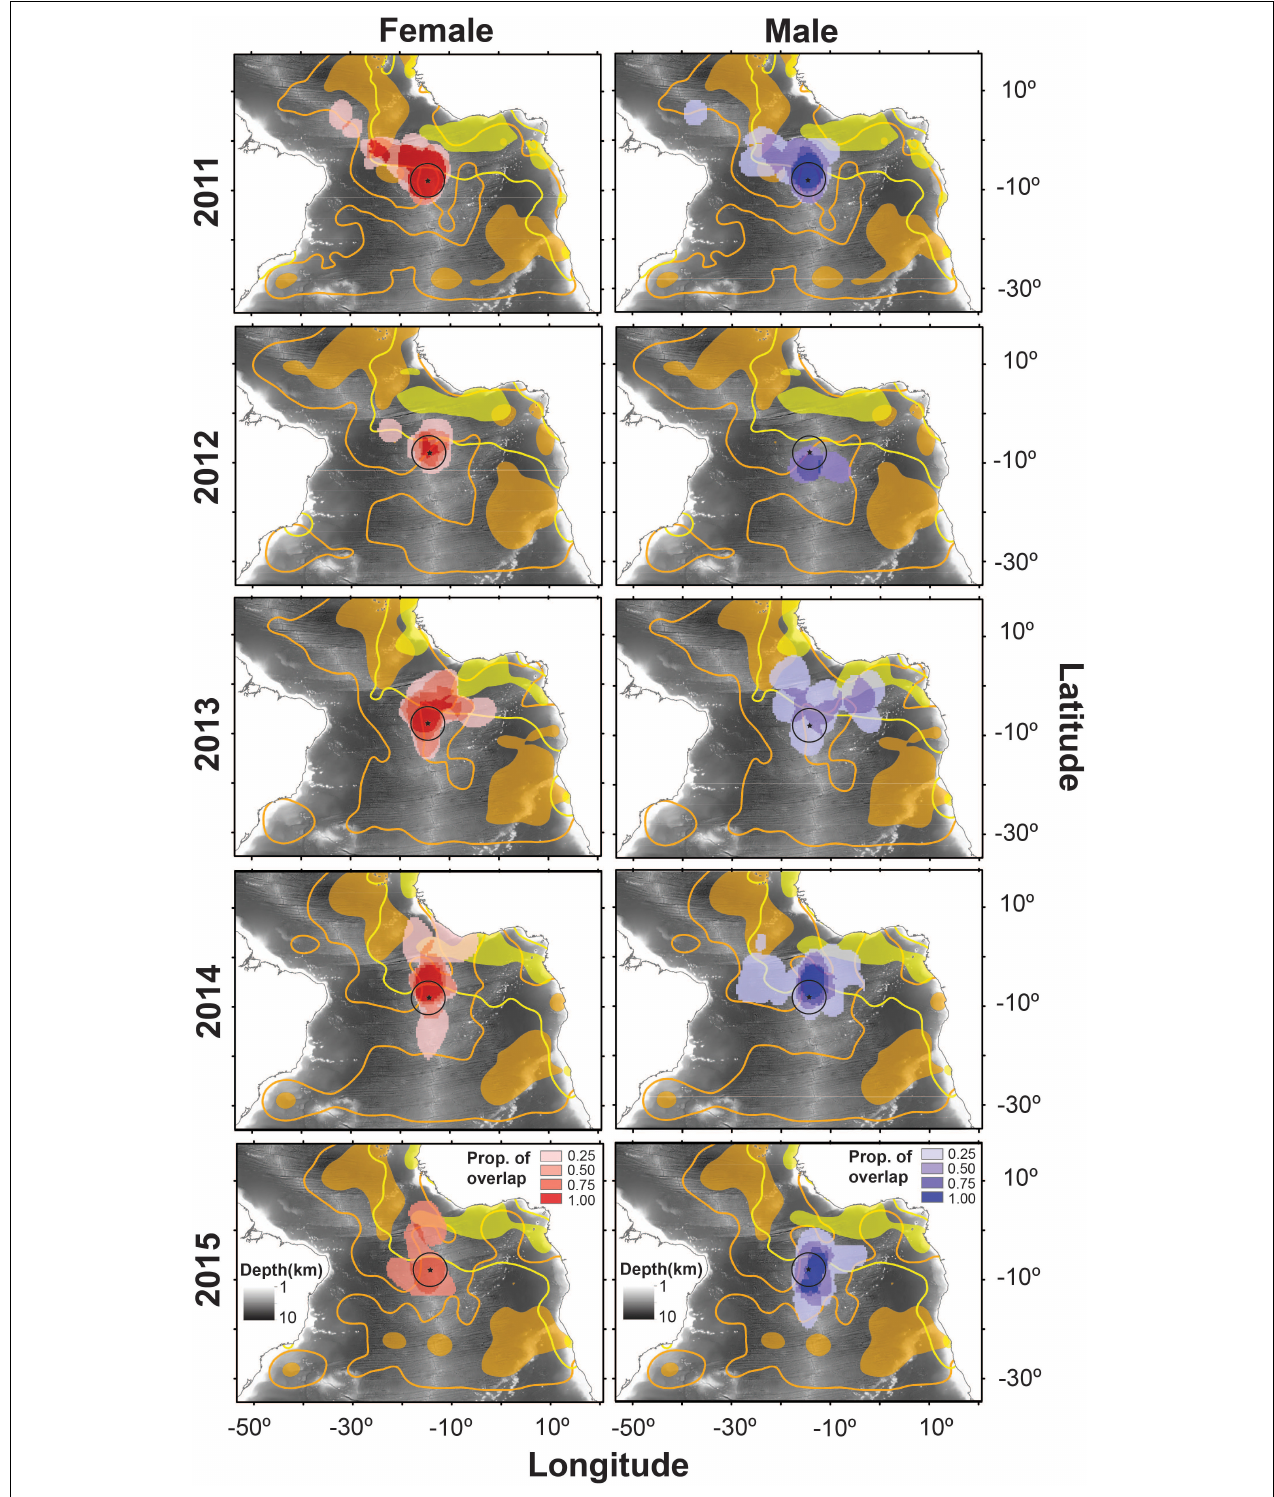
FIGURE 4 | Overlap of the individual 50% kernel utilization distributions (UDs) of female (red) and male (blue) sooty terns from Ascension Island (tracked between 2011 and 2015) with the 50% (filled area) and 95% (contour line) kernel UDs of purse-seiners (yellow) and drifting long-liners (orange). Fisheries distribution data were extracted from https://globalfishingwatch.org/map-and-data/. The black circle represents the MPA that extends 200 nautical miles around Ascension Island. Ocean depth is represented in the background.